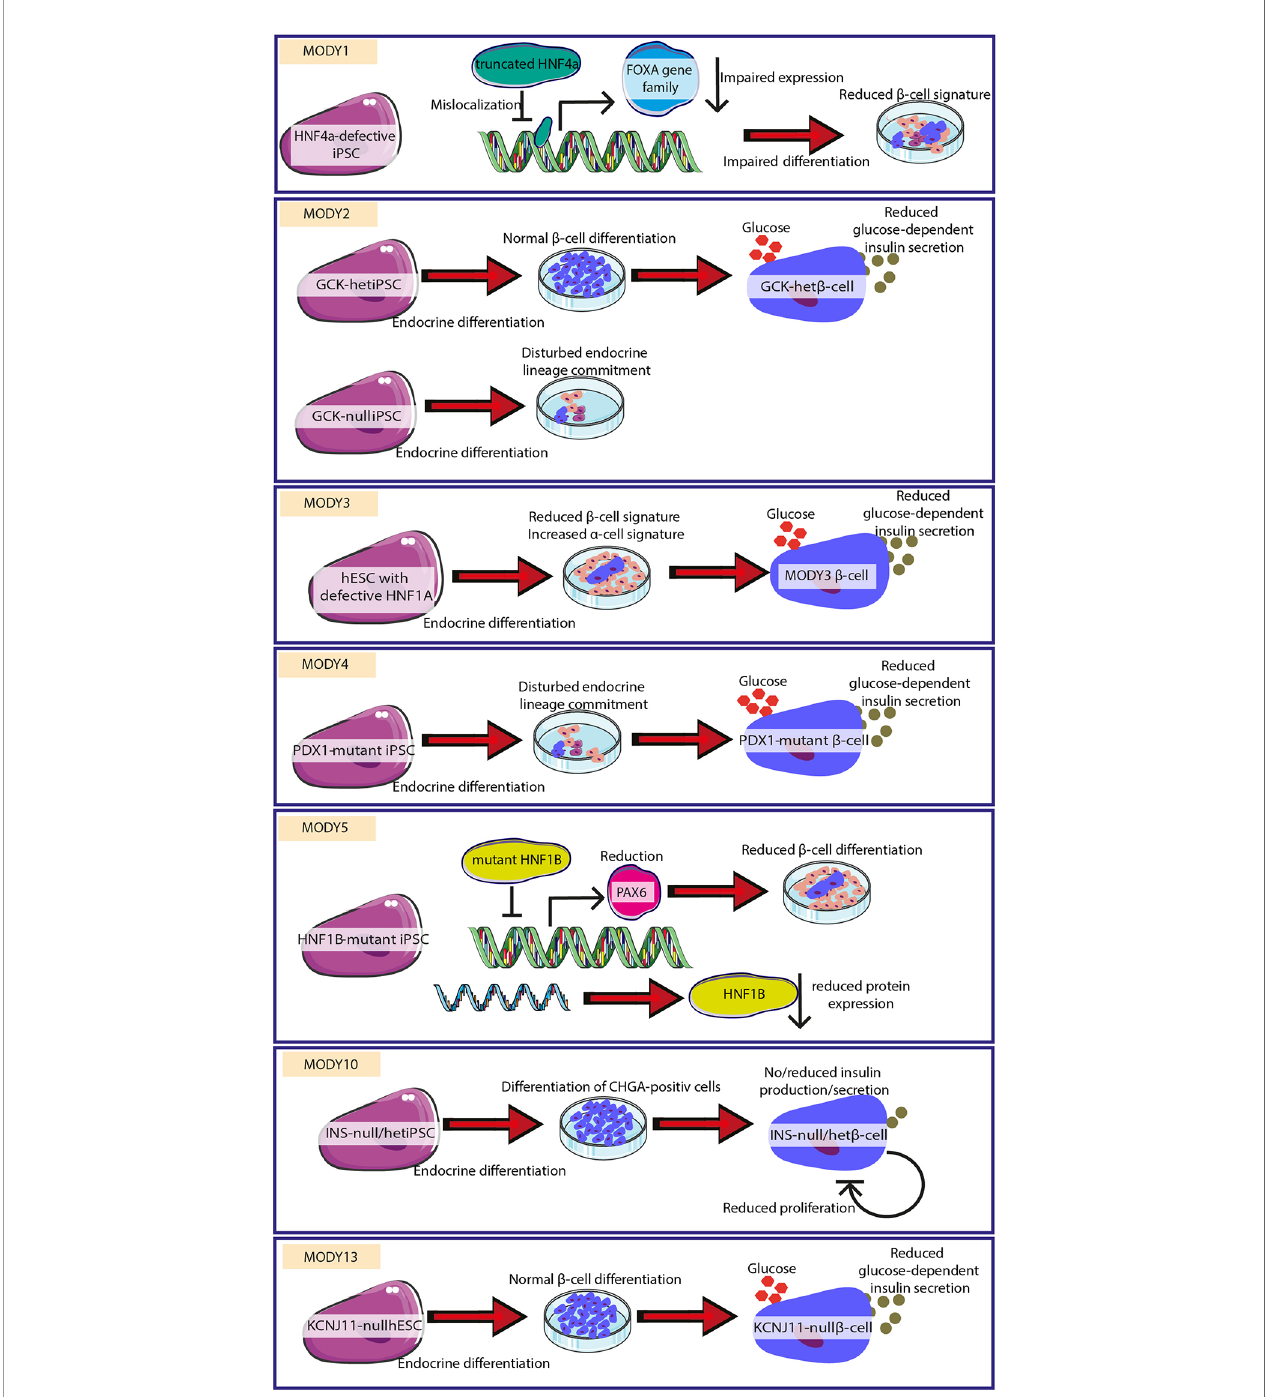
FIGURE 2 | Successful uncovering of pathomechanisms for different MODY forms. Different MODY forms were modeled by employing hESC/hiPSC with respective mutations. Mechanisms leading to monogenic diabetes could be delineated/characterized. In MODY1, mutated HNF4a leads to reduced FOXA gene family expression and impaired b -cell signature. MODY2 is characterized by reduced differentiation or reduced glucose-dependent insulin secretion. MODY3 is caused by reduced b -cell differentiation and insulin secretion. MODY4 shows reduced endocrine lineage entrance and impaired insulin secretion. MODY5 is caused by diminished b -cell differentiation. MODY10 is highlighted by lacking production and secretion of insulin. MODY13 is characterized by impaired glucose-dependent insulin secretion. The fi gure was modi fi ed from Smart Servier Medical Art (https://smart.servier.com/) under a Creative Common Attribution 3.0 Generic